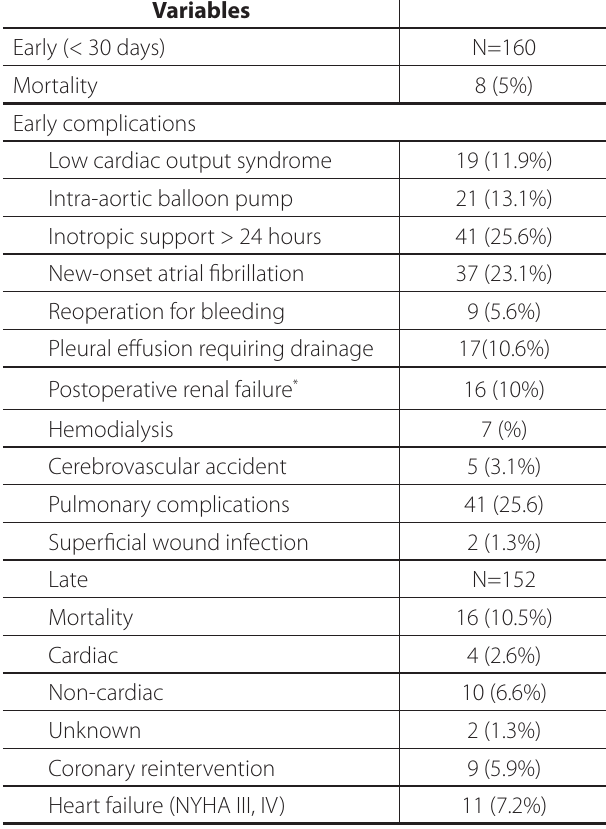
Table 3 . Early and late morbidity and